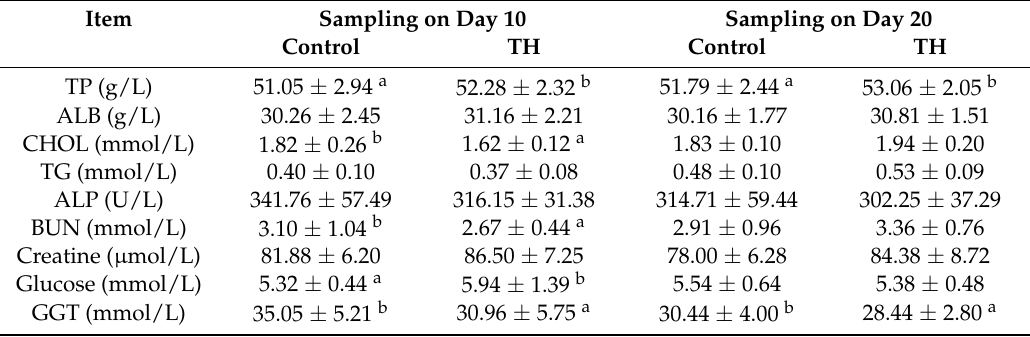
Table 2. Biochemical indices in the plasma of piglets receiving dietary supplementation with or without trihexanoin (TH).